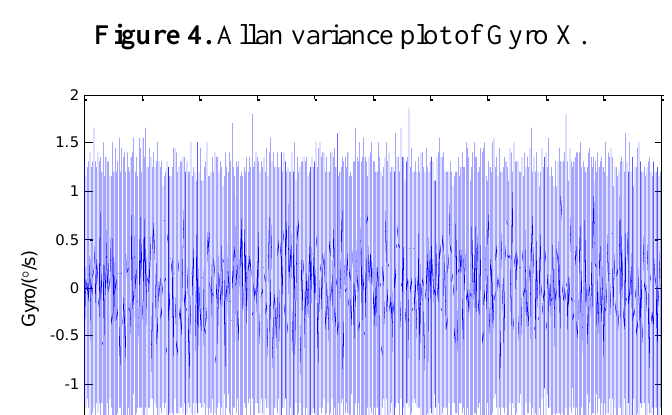
Figure 4. Allan variance plot of Gyro X.